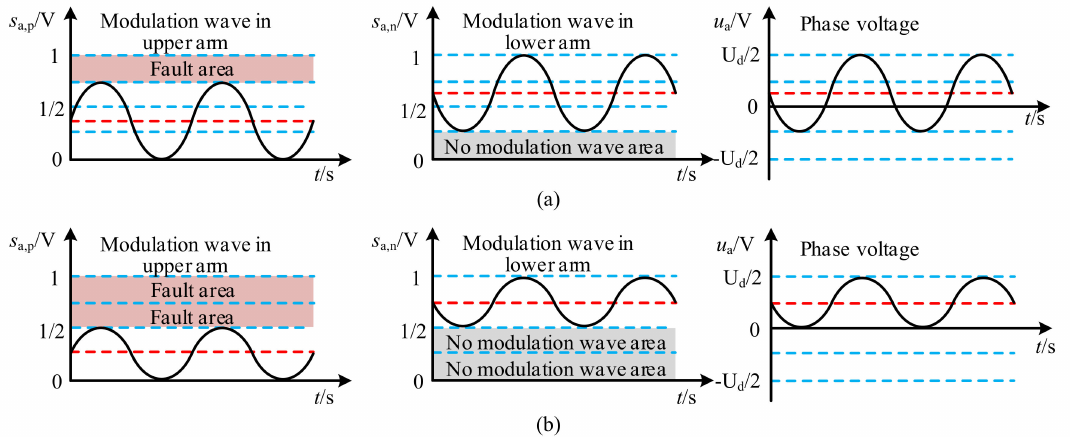
Figure 4. The diagram of neutral point DC side shift after sub-module (SM) fault in the upper arm of a-phase ( N = 4). ( a ) One-fault operation; ( b ) Two-fault operation.